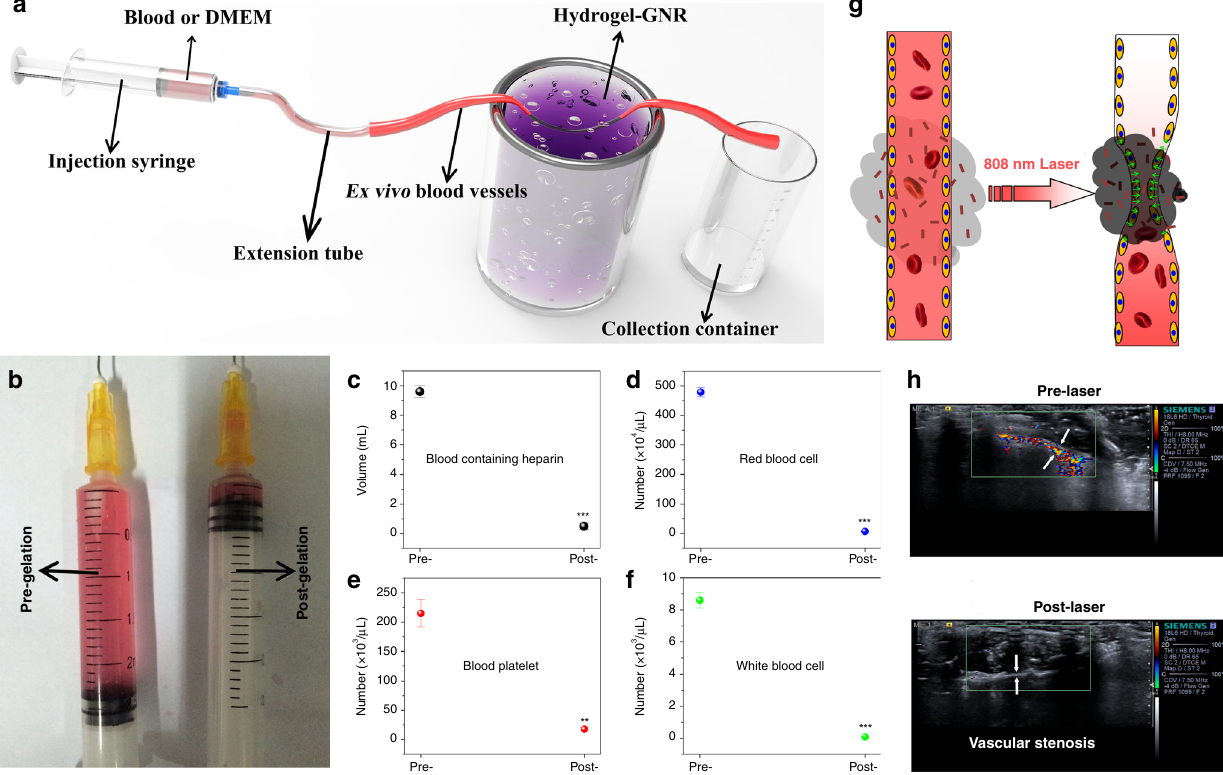
Fig. 3 Occlusion tests of blood supply on ex vivo and in vivo artery model. a Experimental apparatus schematic available for evaluating the occlusion outcome of ex vivo blood vessels with an inner diameter of 1.00 mm based on the extravascular gelation shrinkage-induced internal stress for squeezing blood vessels. b Traversed volume of DMEM through the ex vivo blood vessels before (left) and after (right) gelation of hydrogel – GNR. c , f Collected blood volume ( c ), red blood cells ( d ), blood platelet ( e ), and white blood cells ( f ) traversed through ex vivo blood vessels using rabbit blood containing heparin instead of above DMEM. Data are expressed as mean value ± SD ( n = 3). ** P ˂ 0.01 and *** P ˂ 0.001, and the statistical signi fi cances were obtained using student's t test in comparison to Pre-gelation. g In vivo schematic of extravascular gelation shrinkage-induced internal stress for squeezing blood vessels upon exposure to 808 nm laser. h CDFI images of abdomen artery of nude mice around which hydrogel – GNR solution was administrated, and in particular, CDFI images were captured before and after 808 nm laser irradiation, respectively, wherein white arrows indicate the blood vessels of abdomen